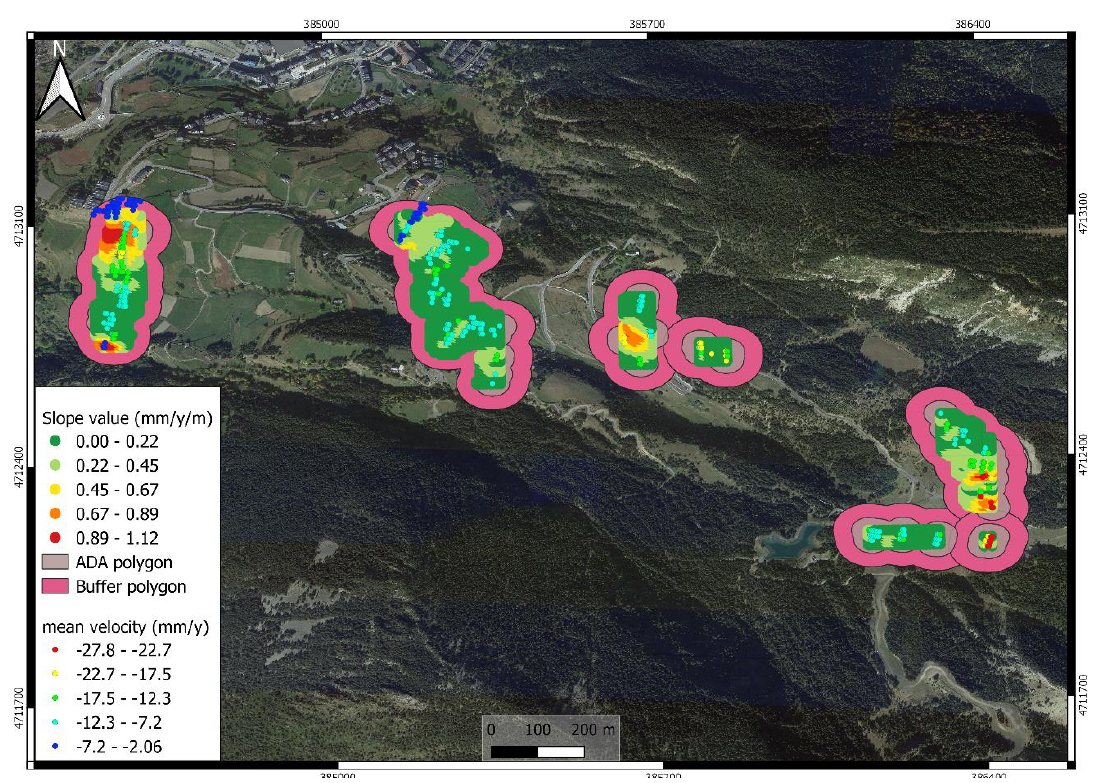
Figure 2. A Terrain Differential Deformation Map with Gaussian filter in rural areas. Slope values are from 0 to 1.12 (mm/yr/mm). Dark and light pink polygons show the Buffer and ADA polygons, respectively.